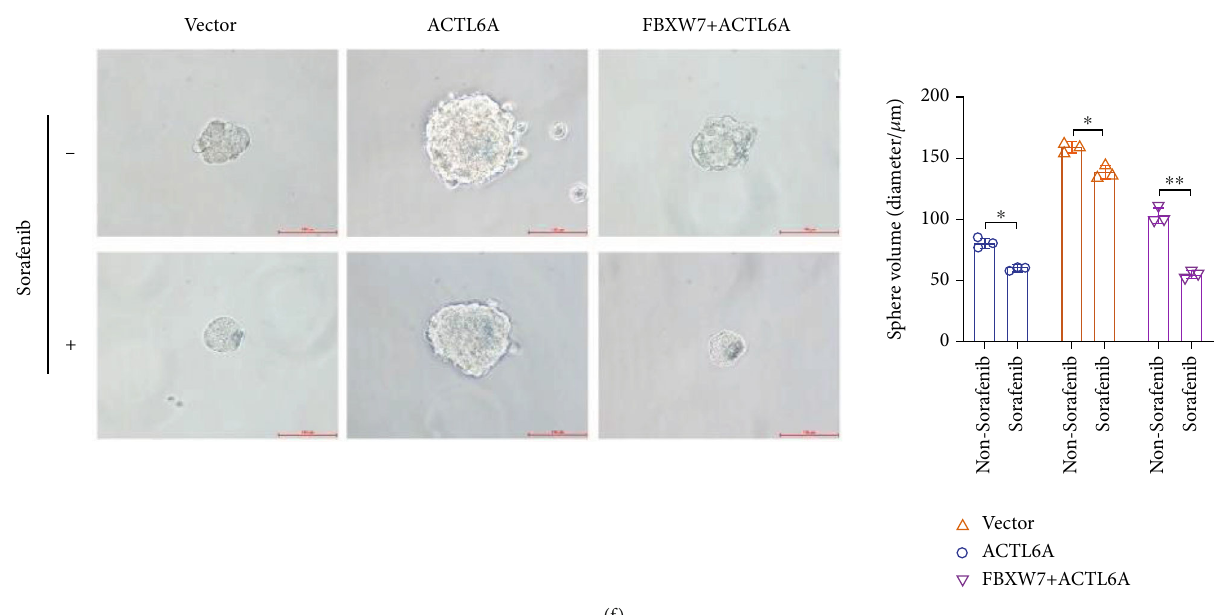
Figure 8: FBXW7 regulates ACTL6A expression levels to inhibit HCC growth in vivo and resistance of sorafenib in vitro . (a – c) The indicated engineered MHCC-97H or control cells were injected into subcutaneous and representative images of tumors (a), tumor growth curve (b), and tumor weight (c). (d) The expression of ACTL6A, CD133, Nanog, and OCT in xenograft tumor tissues by IHC staining. (e) Overexpression of ACTL6A in MHCC-97H decreased the sensitivity to sorafenib, which was rescued by FBXW7 upregulation. (f) E ff ect of ACTL6A overexpression combined with sorafenib on tumor spheroid formation in MHCC-97H cells. Graph represents mean ± SD ; ∗ P < 0 : 05 , ∗∗ P < 0 : 01 , ∗∗∗ P < 0 : 001